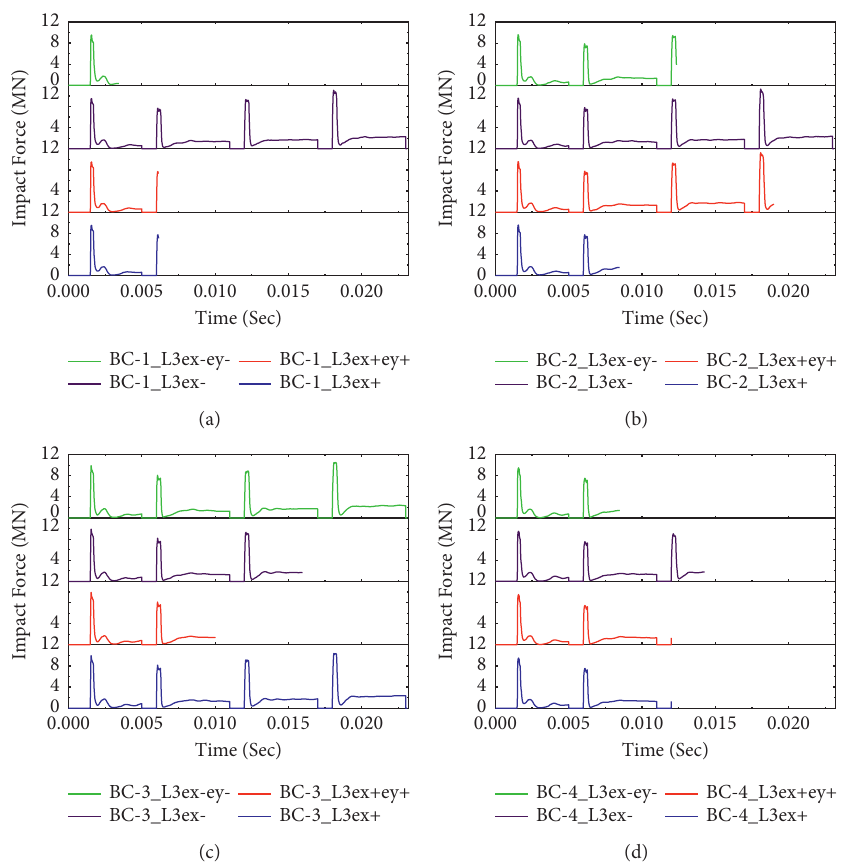
Figure 19: Effect of eccentric axial load on impact capacity of BRC columns: (a) normal, (b) two-bundle, (c) three-bundle, and (d) four-bundle reinforcement